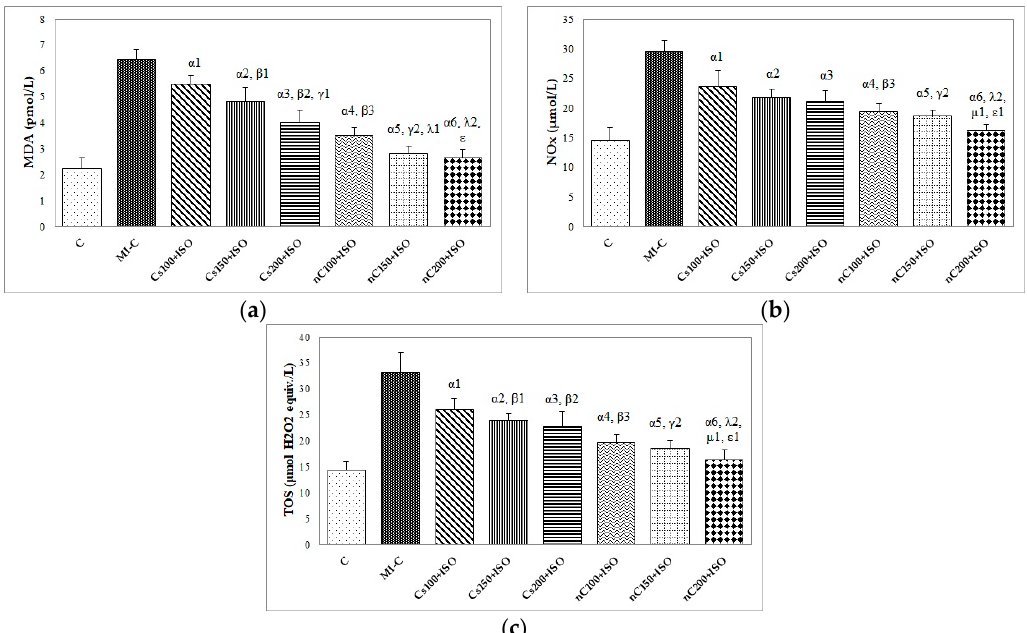
Figure 7. Distribution of oxidative stress intensity in the myocardial tissue: ( a ) nitric oxide (NOx), ( b ) malondialdehyde (MDA), and ( c ) total oxidative status (TOS) by groups. C = control; MI-C = isoproterenol without any pre-treatment; Cs = curcumin solution, in doses of 100 mg / kg bw (Cs100), 150 mg / kg bw (Cs150), and 200 mg / kg bw (Cs200); nC = curcumin nanoparticle solution, in doses of 100 mg / kg bw (nC100), 150 mg / kg bw (nC150), and 200 mg / kg bw (nC200); the letter-number codes correspond to the p -values < 0.05: α as compared with MI-C, β as compared with CS100 + ISO, γ as compared with CS150 + ISO, λ as compared with nC100 + ISO, µ as compared with nC150 + ISO, ε as compared with Cs200 + ISO.